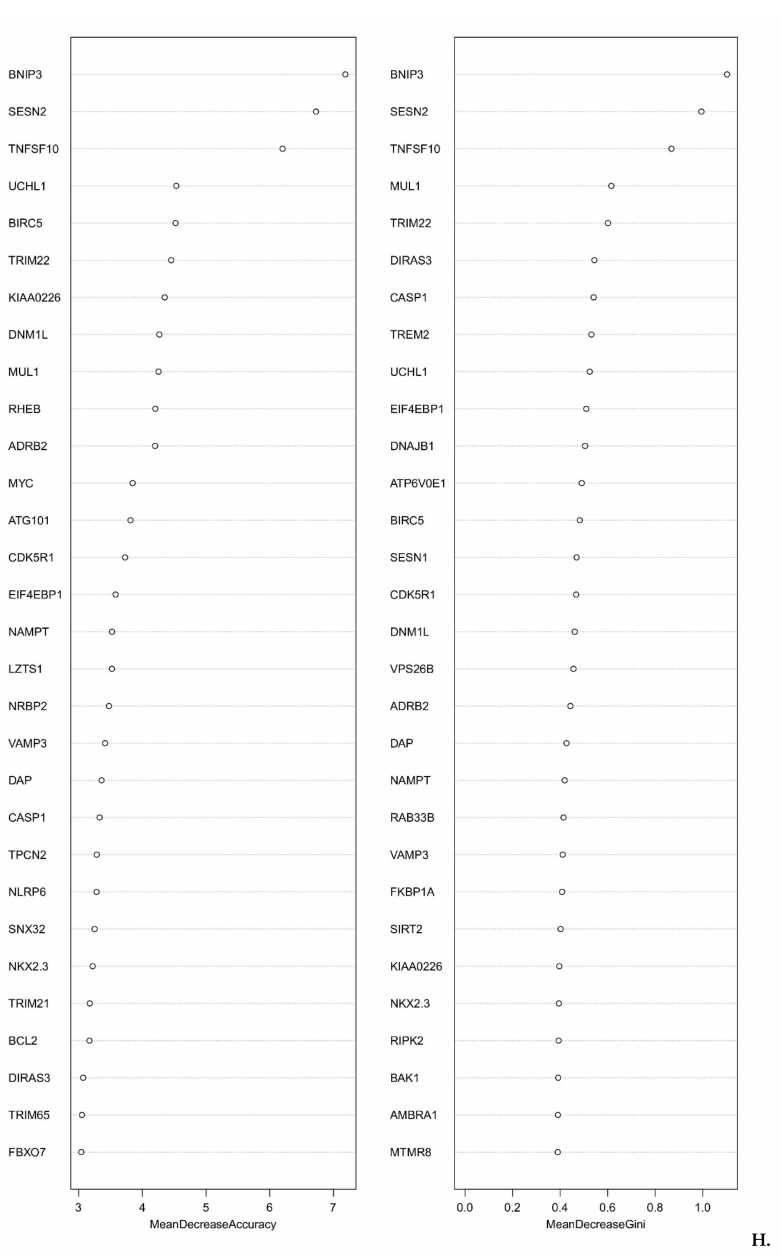
Figure 2. WPSC induces autophagy in lung cancer cell lines. A549 and H460 cell lines were treated with 0.5% WPSC for 24 h. LC3I/II levels were monitored by western blotting using standard procedures with anti-LC3 and GAPDH as a loading control for ( A ) band intensity was quantified in ( B ). The immunofluorescence analysis of p62 protein was performed following 72 h WPSC treatment; cells were treated with 100 nM Baf-A1 for 24 h as positive control ( C ). Western blotting for p62 protein was performed by standard procedures with anti-p62, and anti-GAPDH as a loading control ( D ) band intensity was quantified in ( E ). Cells were stained with a combination of Annexin V-FITC and propidium iodide (PI) to measure apoptosis, following 100nM Baf-A1 pre-treatment and WPSC treatment for the indicated time points, in both cell lines ( F ). TCGA lung adenocarcinoma bulk RNA-seq datasets of all autophagy genes between smokers and non-smokers ( G ). Two feature importance techniques were used—meanDecreaseAccuracy and meanDecreaseGini—to classify the top predictors of the autophagy-related genes with smoking status ( H ). Representative images of confocal microscopic analysis of p62 (green) and DAPI (blue) are shown. Scale bar, 10 µ m. Results represent means of three independent experiments, and data represent mean ± standard error of